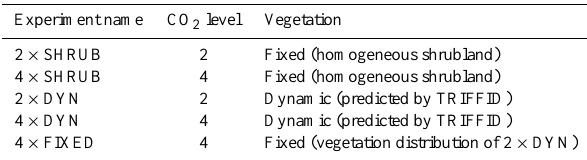
Table 2. Summary of all Eocene model